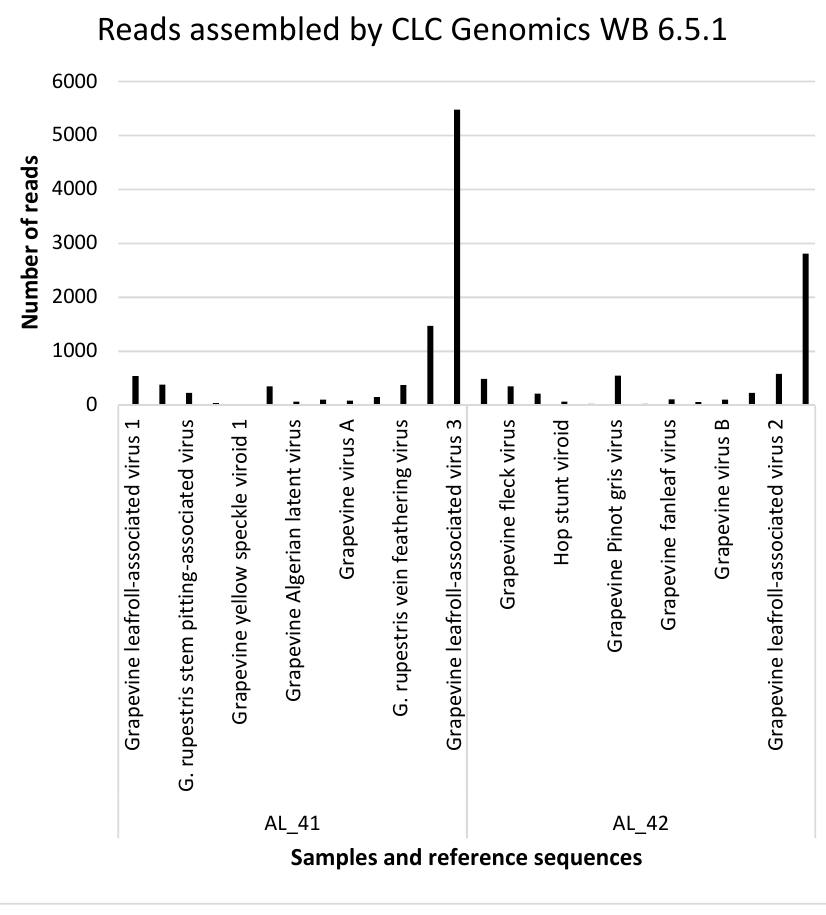
Figure 3. Numbers of reads mapped on the reference viral and viroid sequences. CLC Genomics WB 6.5.1 (CLC Bio, Aarhus, Denmark) was used to plot the data.